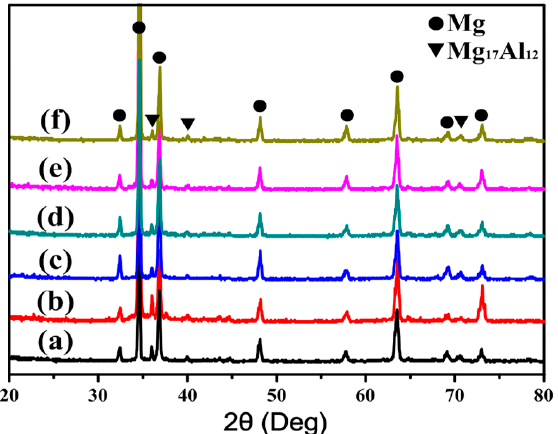
Figure 5. XRD patterns of: ( a ) extruded AT81 and 0.5 vol % n-SiC p /AT81 composites reinforced by n-SiC p with different pre-oxidation parameters: ( b ) untreated; ( c ) 973 K/2 h; ( d ) 1073 K/2 h; ( e ) 1173 K/2 h; and ( f ) 1273 K/2 h.